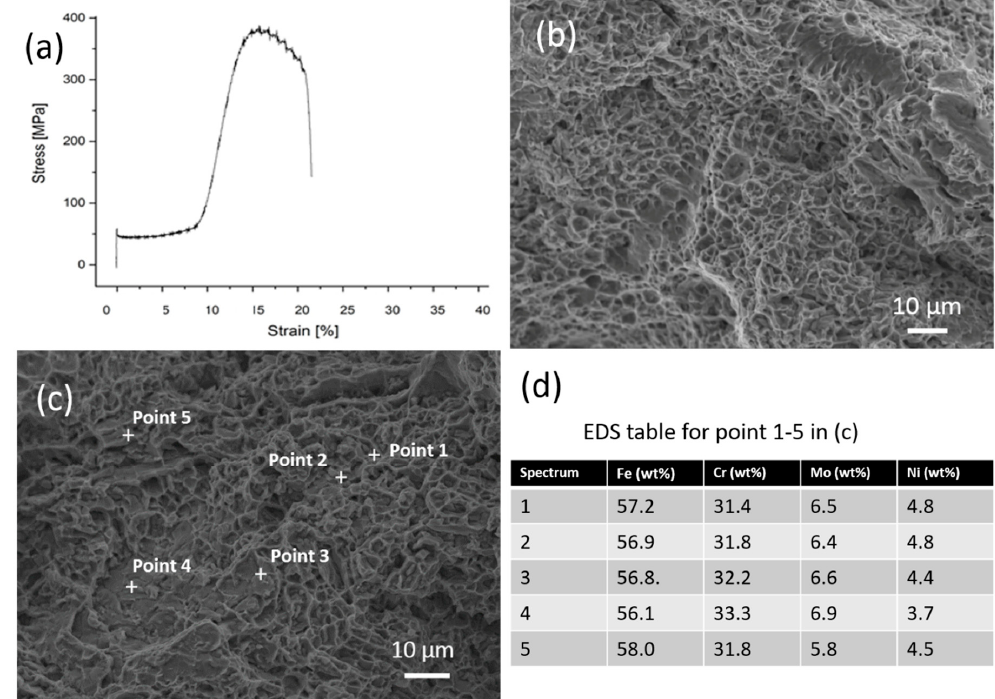
Figure 5. ( a ) Tensile test curve of post heat treated SLM 2507 obtained at 1200 °C, ( b , c ) Fracture analysis of the Showing overall dimples and cleavages, EDS taken from ( c ) where the percentage of Cr and Mo representing sigma is shown in EDS data Table in ( d ).